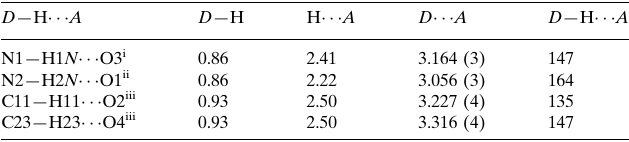
Hydrogen-bond geometry (A˚ , (cid:1)